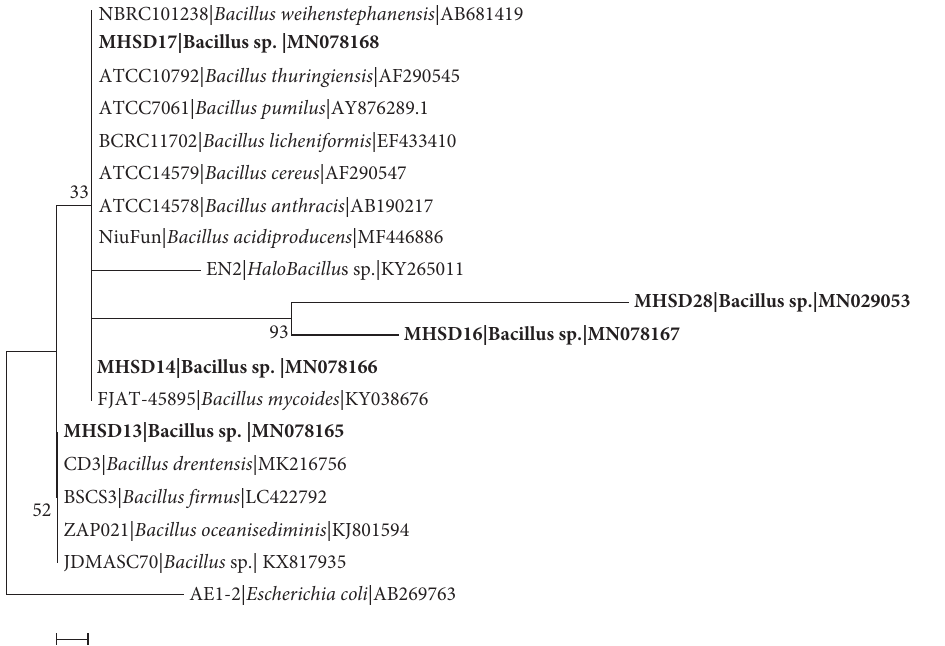
Figure 5: Maximum likelihood phylogenetic tree based on analysis of partial 16S rDNA nucleotide sequences of Bacillus sp . strain MHSD28. Bacillus sp. strain MHSD13. Bacillus sp. strain MHSD14, Bacillus sp. strain MHSD16, and Bacillus sp. strain MHSD17 with related strains from Bacillus genus. Numbers above or below the nodes indicate bootstrap values generated after 1000 replications. Escherichia coli AE-1 (AB269763) was used as an